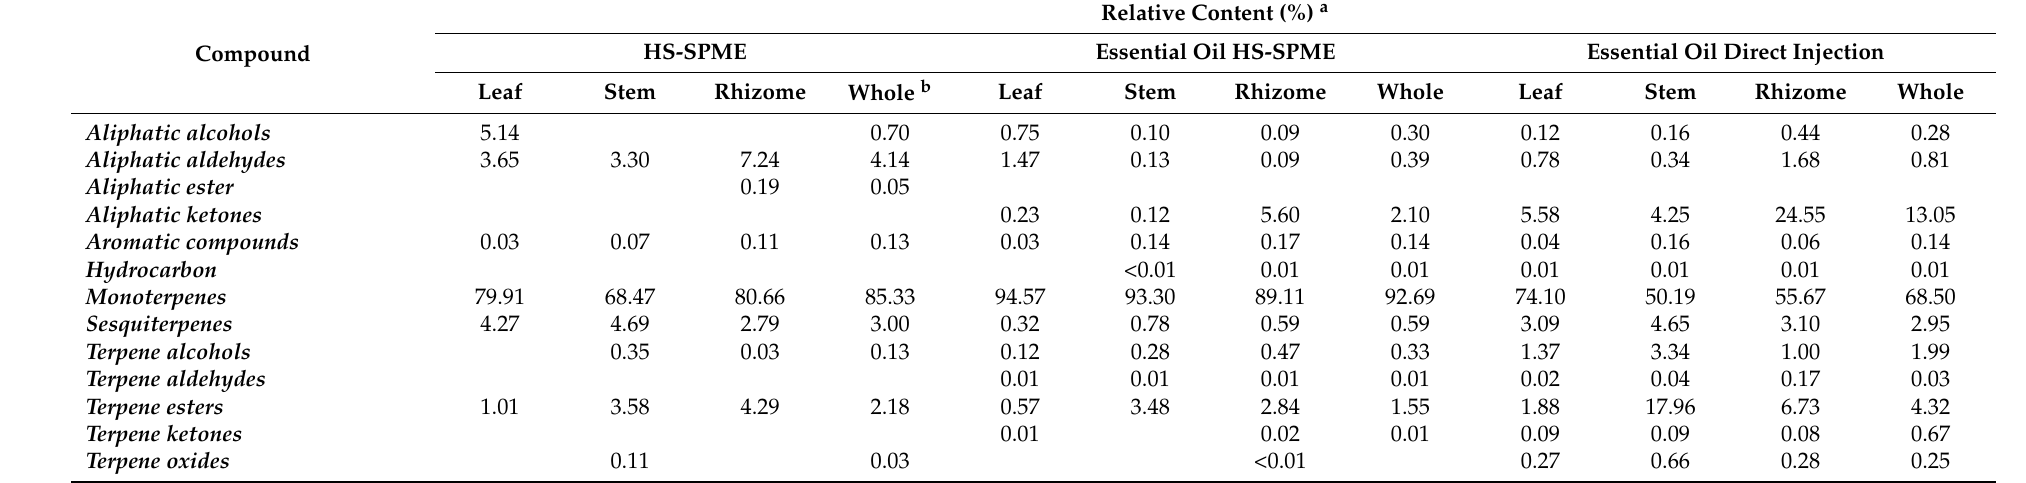
Table 2. Concentrations of chemical groups from different parts of H. cordata as analyzed by different